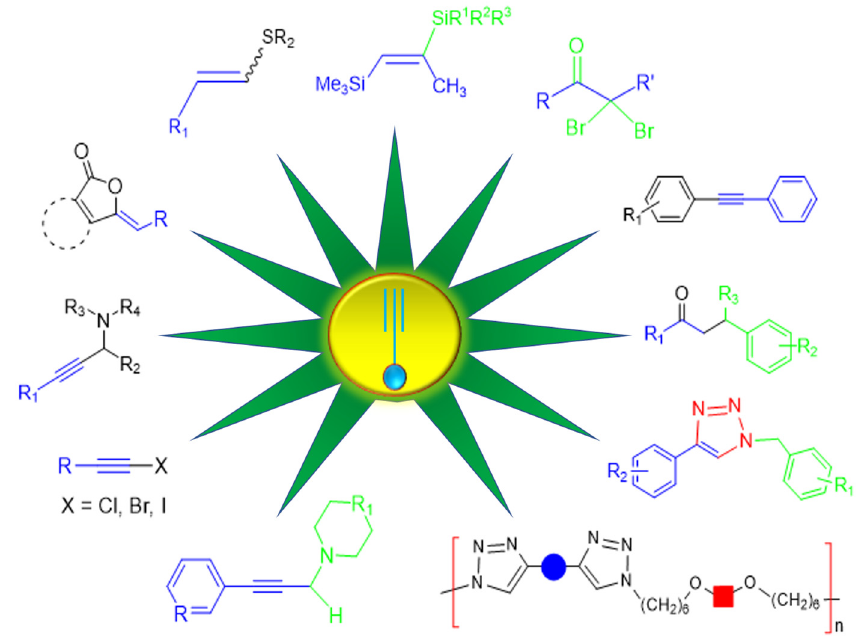
Figure 2. The wide array of alkyne functionalized products achieved through the reactions focused on in this review via recyclable